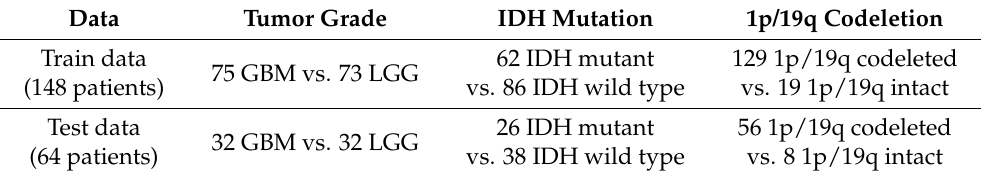
Table A2. Summary of the data regarding different tumor grades, IDH mutation status, and 1p/19q codeletion status.